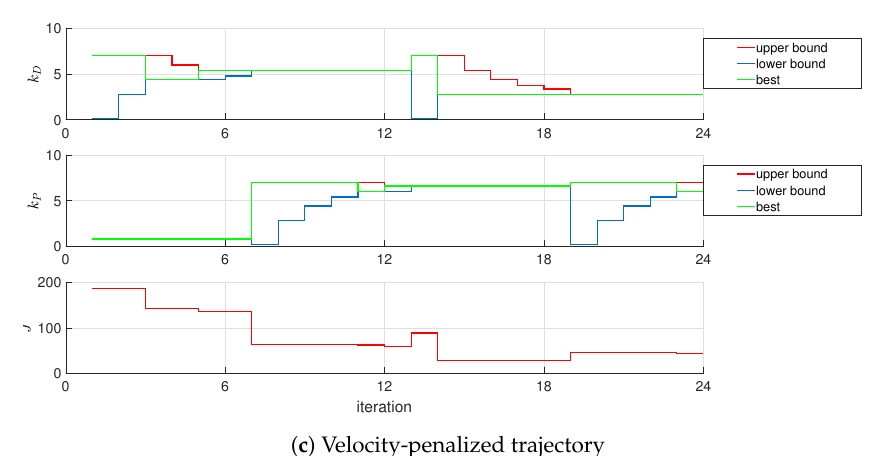
( c ) Velocity-penalized trajectory Figure 9. Optimization of landing on the basis of OT readings